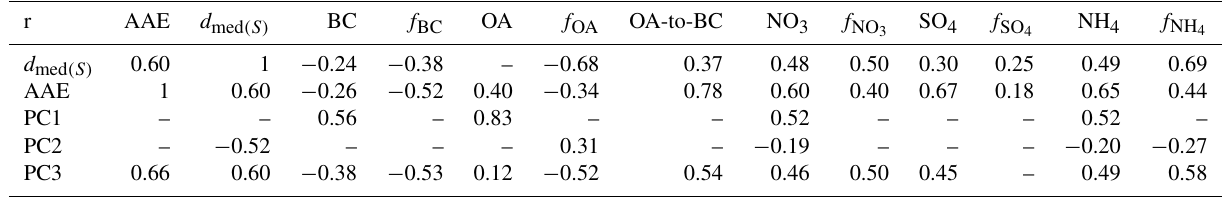
Table 1. Statistically significant ( p < 0.001) Pearson’s correlation coefficients ( r ) between absorption Ångström exponent (AAE) at 467– 660nm; scores of major aerosol types identified by PCA (PC1 is the road-traffic-related aerosol, PC2 is the residential heating related aerosol, and PC3 is the droplet-mode aerosol); mass concentration and mass fractions ( f x ) of black carbon (BC), organics (OA), nitrate (NO − ), sulfate (SO 2 − ), and ammonium (NH + ); optically relevant aerosol size representative of the entire aerosol population (calculated as 3 4 4 median mobility diameter of the particle surface size distribution, d med (S) ); OA-to-BC ratios (see Tables S1 and S2 of the Supplement for additional relevant